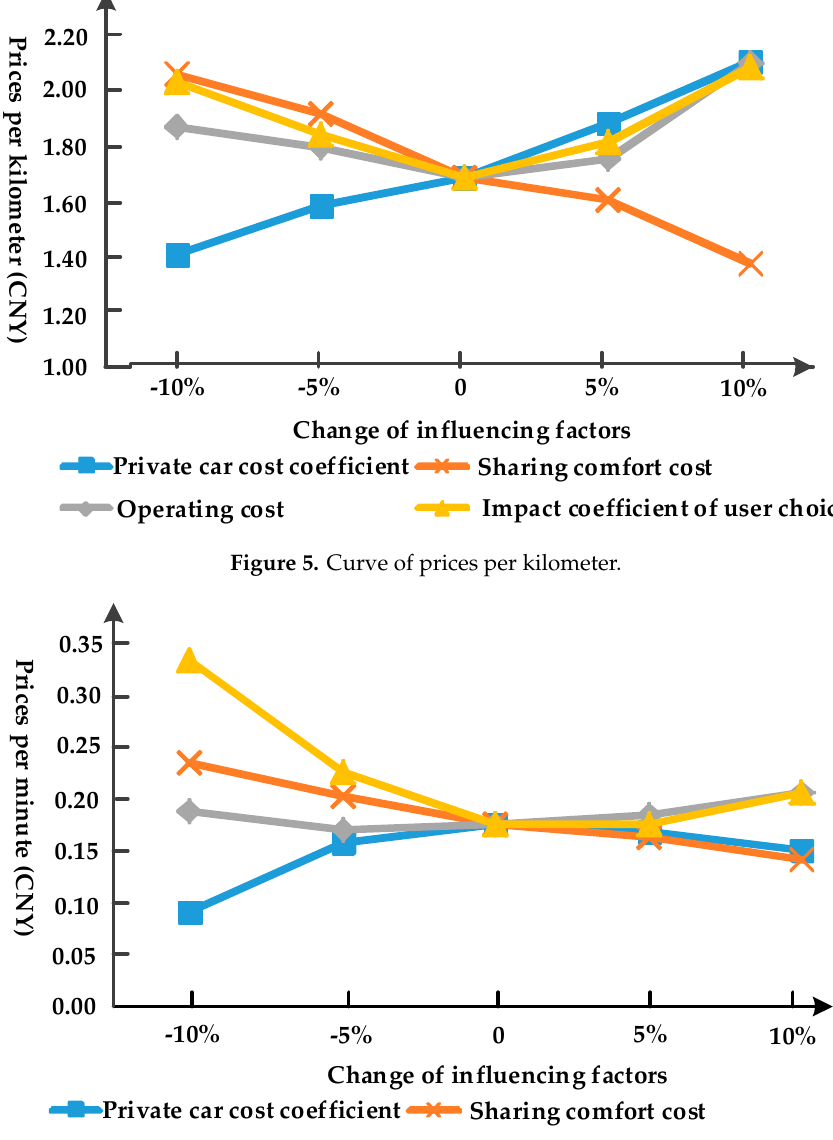
Figure 6. Curve of prices per minute.